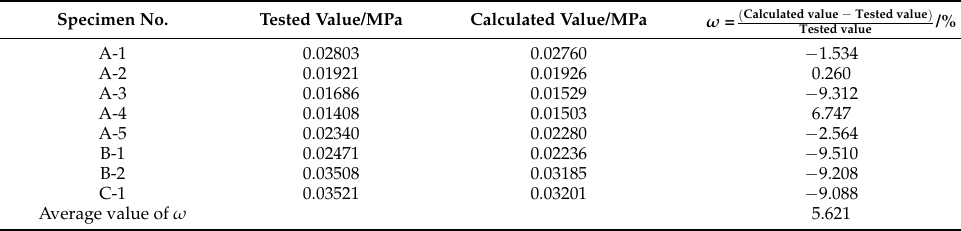
Table 5. Tested and calculated values of peak